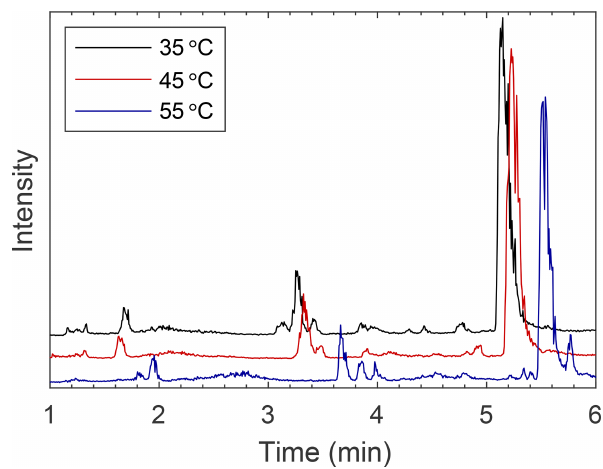
Figure 4. Comparison of EICs showing separation at various tem- peratures on the BEH column with MeOH as the modifier. Sep- aration is improved at higher temperatures. On all columns, most peaks elute slightly earlier at lower temperatures and are somewhat sharper (see Figs.